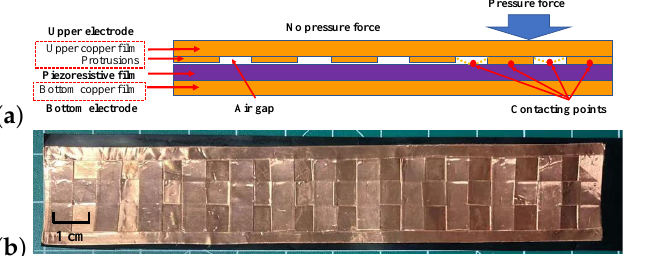
Figure 3. The design and the mechanism of the FSU: ( a ) comparison between with and without applied force on the FSU; and ( b ) prototype of cross-shape pattern in the FSU for creating protrusions.